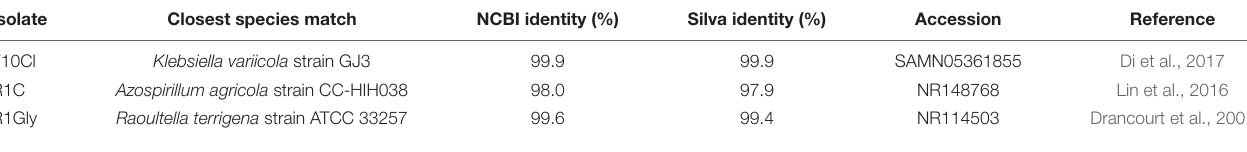
FIGURE 1 | (A) Fluorescence of nifH::gfp strain R1Gly in the leaf section of re-infected switchgrass (100 × ). (B) Root lengths and (C) below ground surface wet masses of R1Gly-infected switchgrass (R1Gly) versus sterile switchgrass (negative). Error bars represent one standard deviation of biological triplicates.